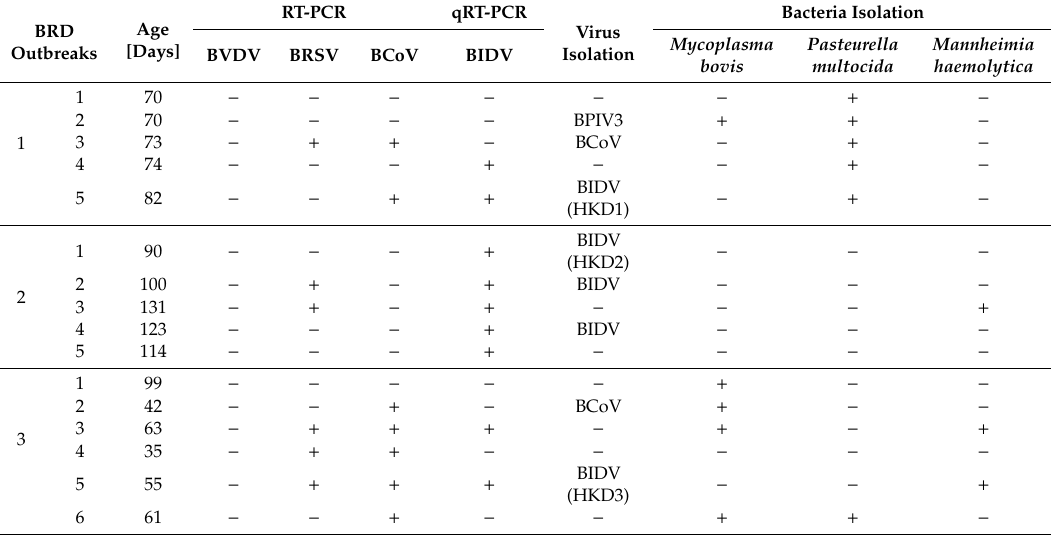
Table 1. Summary of diagnostic tests for three bovine respiratory disease (BRD) outbreaks that occurred in Hokkaido, Japan from 2018 to 2020.